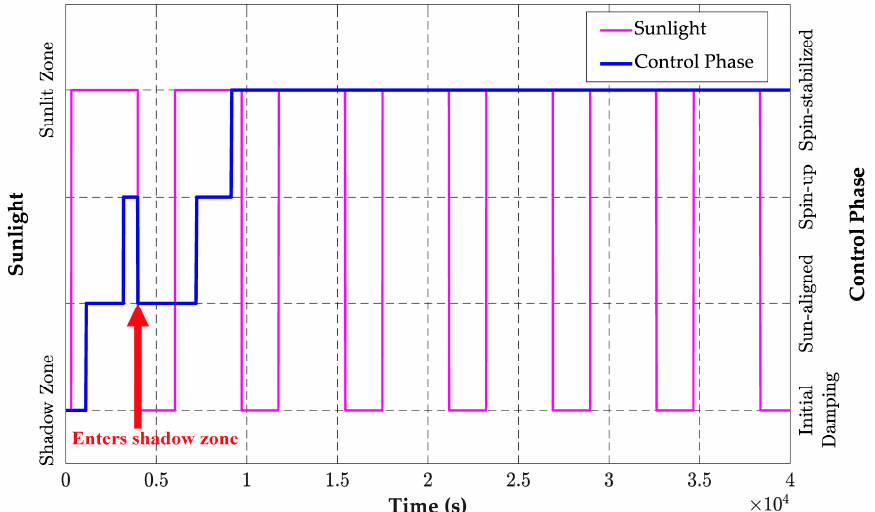
Figure 4. The variation curve of the sunlight occlusion where the satellite is located and the satellite control phase.